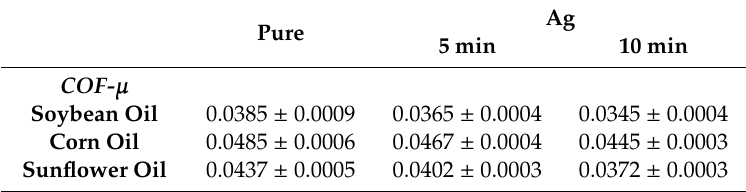
Table 3. COF performance at 5 and 10 min of Ag nanostructures by laser ablation.